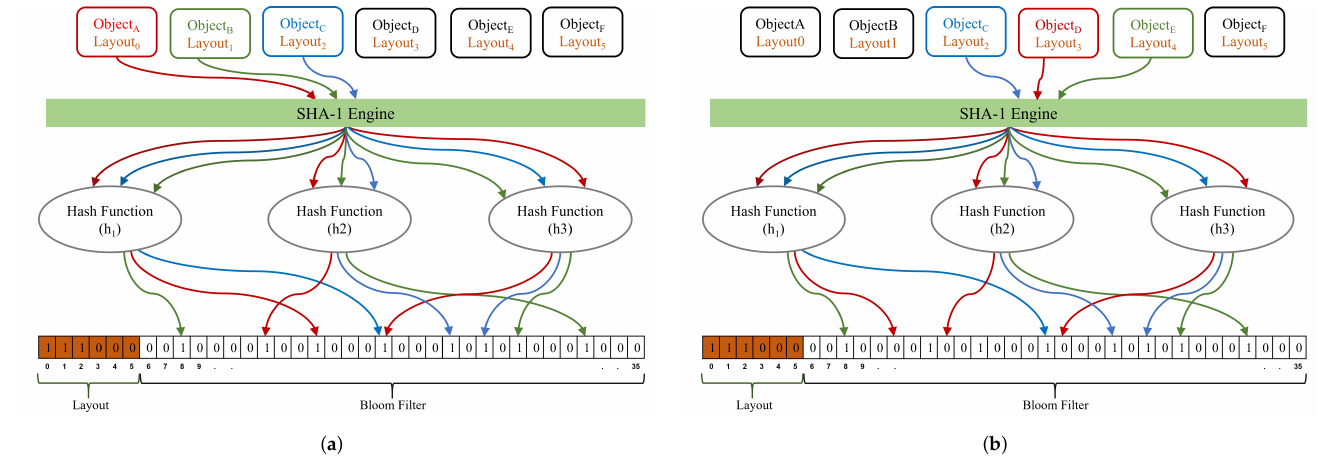
Figure 3. Illustrative example of data- and layout-aware Bloom filter data structure. ( a ) Insert operation. ( b ) Query